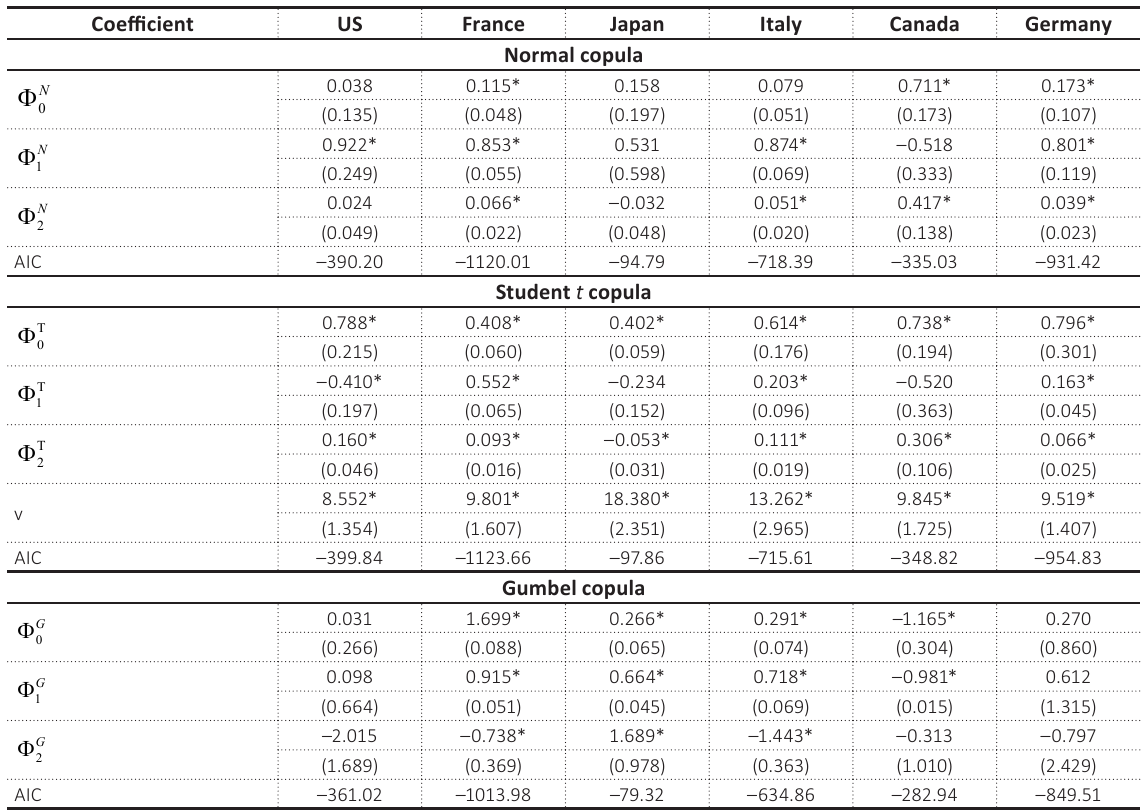
Table 3. Time-varying dependence